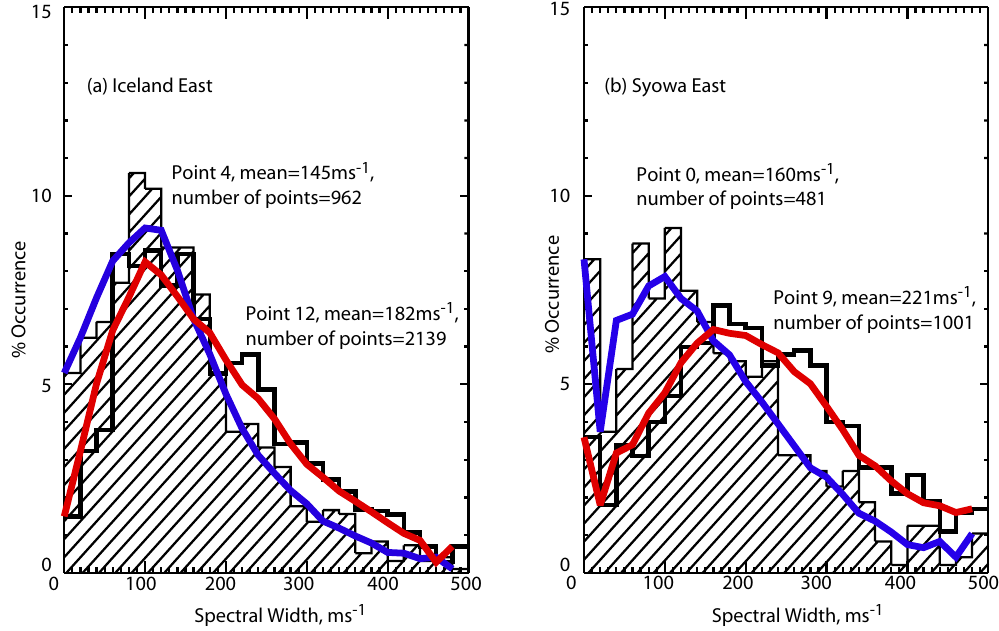
Fig. 4. Histograms showing typical examples of spectral width distributions from (a) Iceland East and (b) Syowa East. These are taken from the 04:00 to 06:00MLT interval from the winter data from the respective hemispheres. The thick blue lines show the boxcar average of the shaded distributions and the thick red lines show the same for the unshaded